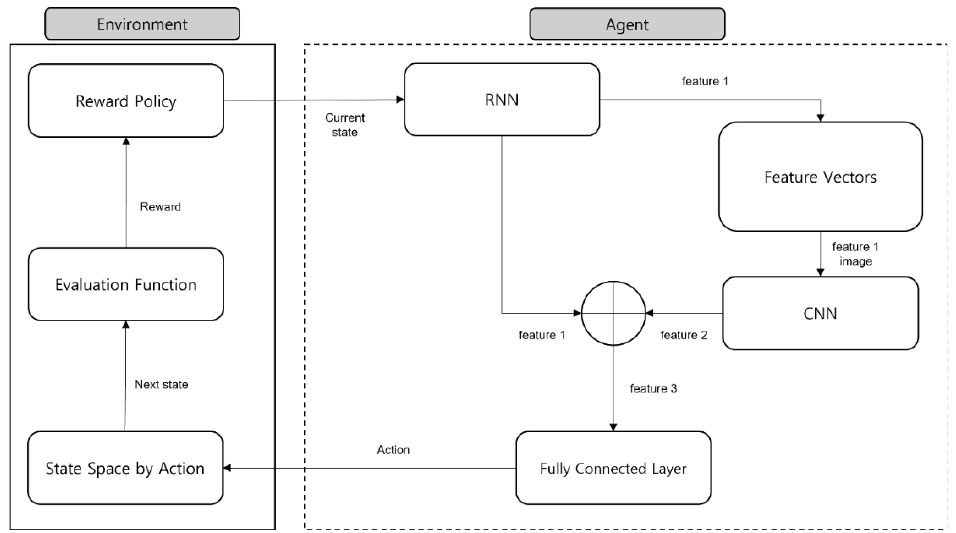
Figure 1. Dynamical pseudo-random generator using reinforcement learning.